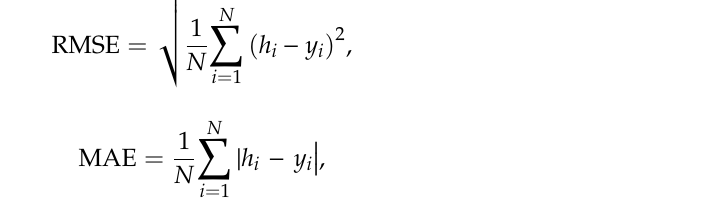
Figure 7. Equipment of an air cushion furnace experimental platform: ( a ) external view of the